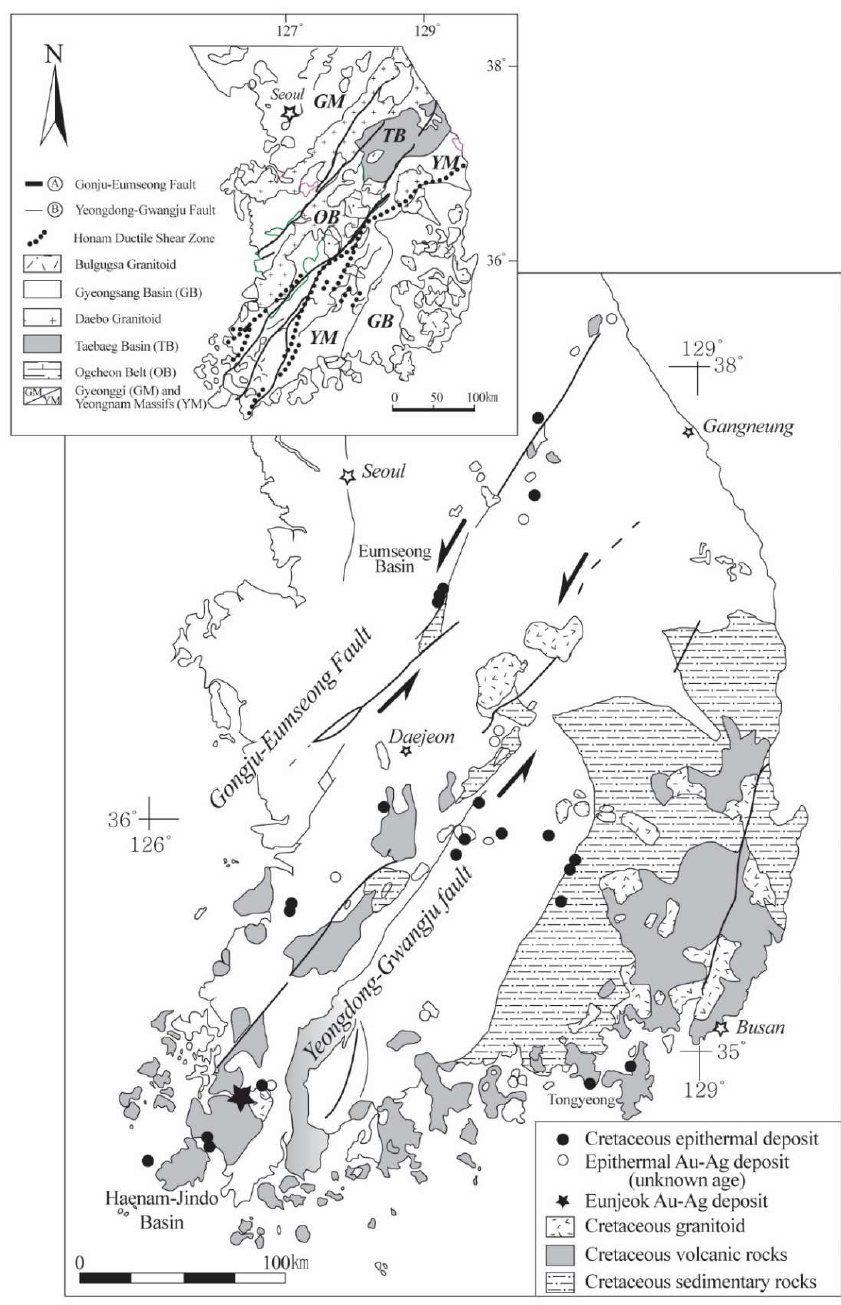
Figure 1. Simplified geological map of South Korea showing the distribution of Cretaceous basins and major epithermal gold–silver deposits. This figure was entirely modified from [2].